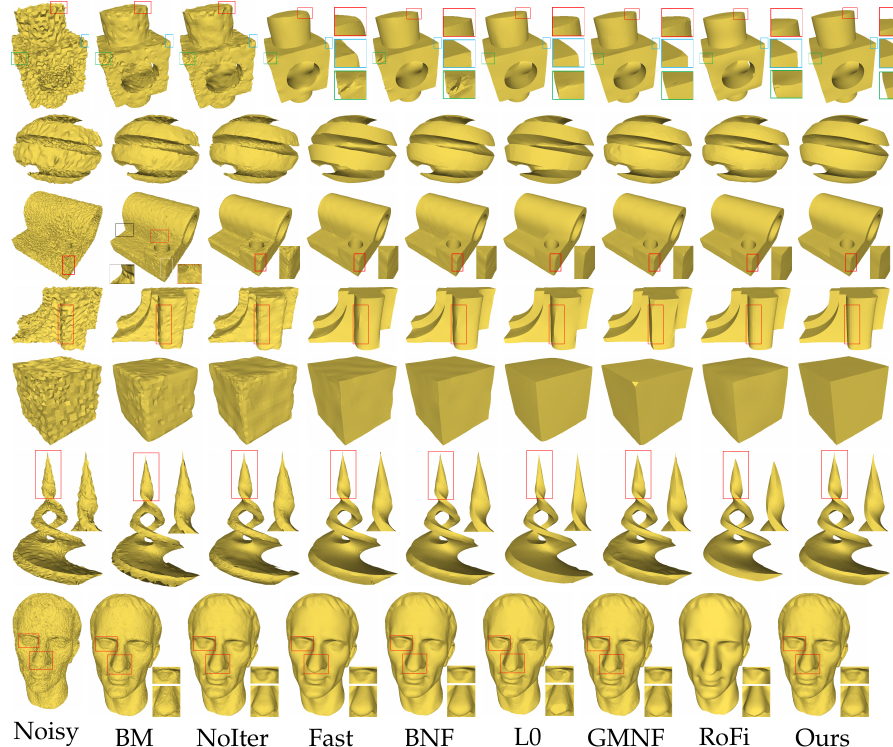
Figure 14. Comparison of the denoising results for the CAD model with additive Gaussian. The results From left to right: [3–5,23,27,28,32] and ours.